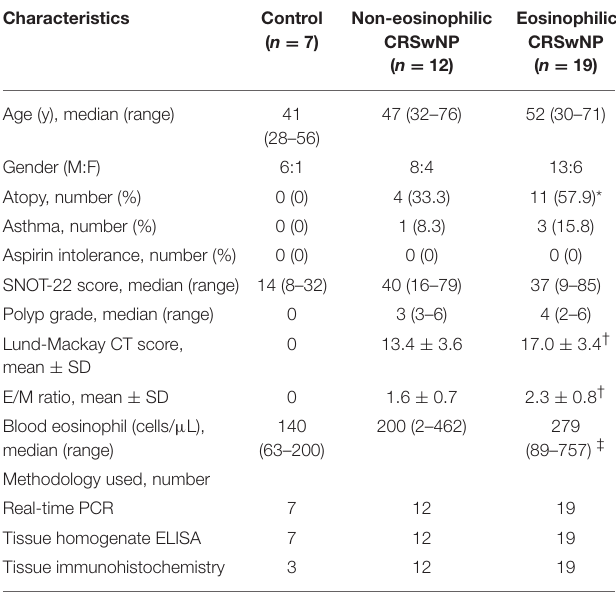
TABLE 1 | Clinical characteristics of control subjects and patients with CRS with